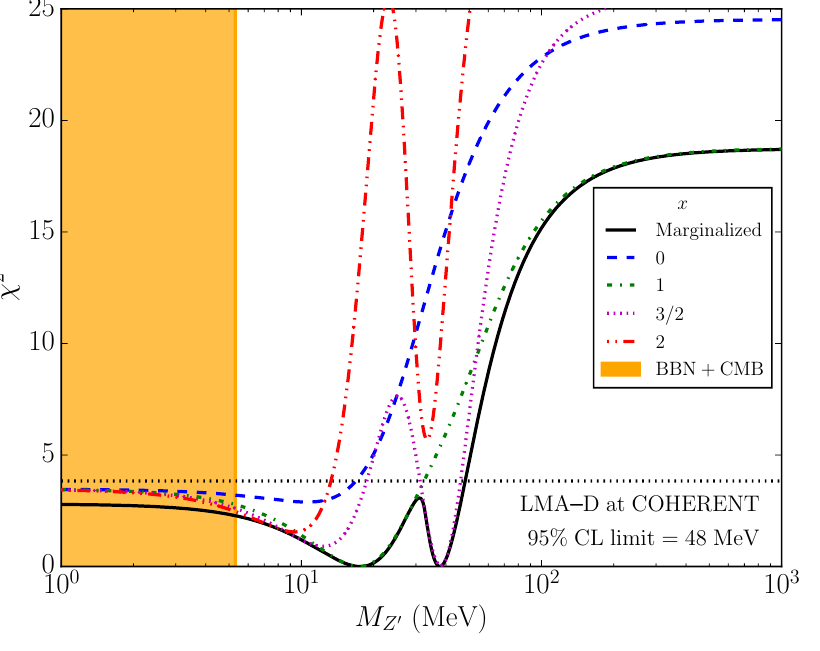
= x = (cid:15) d;V (cid:0) 1 as ee ee 4 2